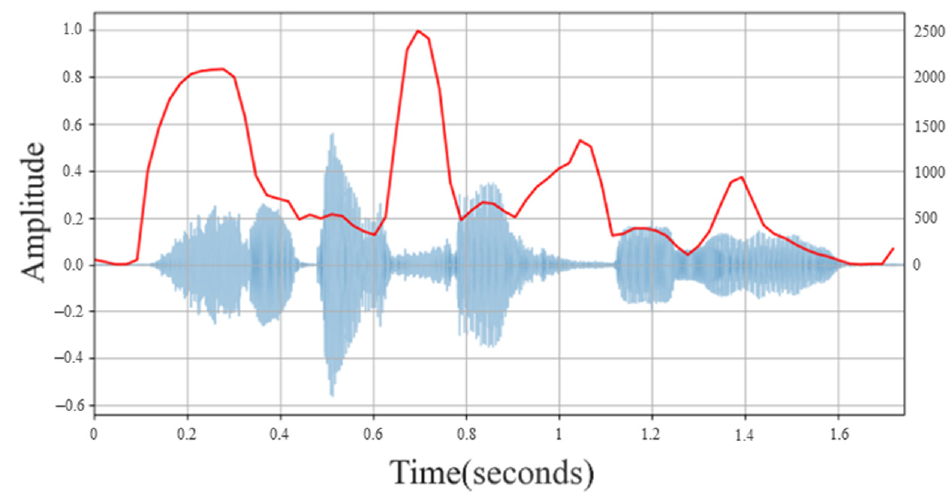
Figure 1. Spectral Centroid